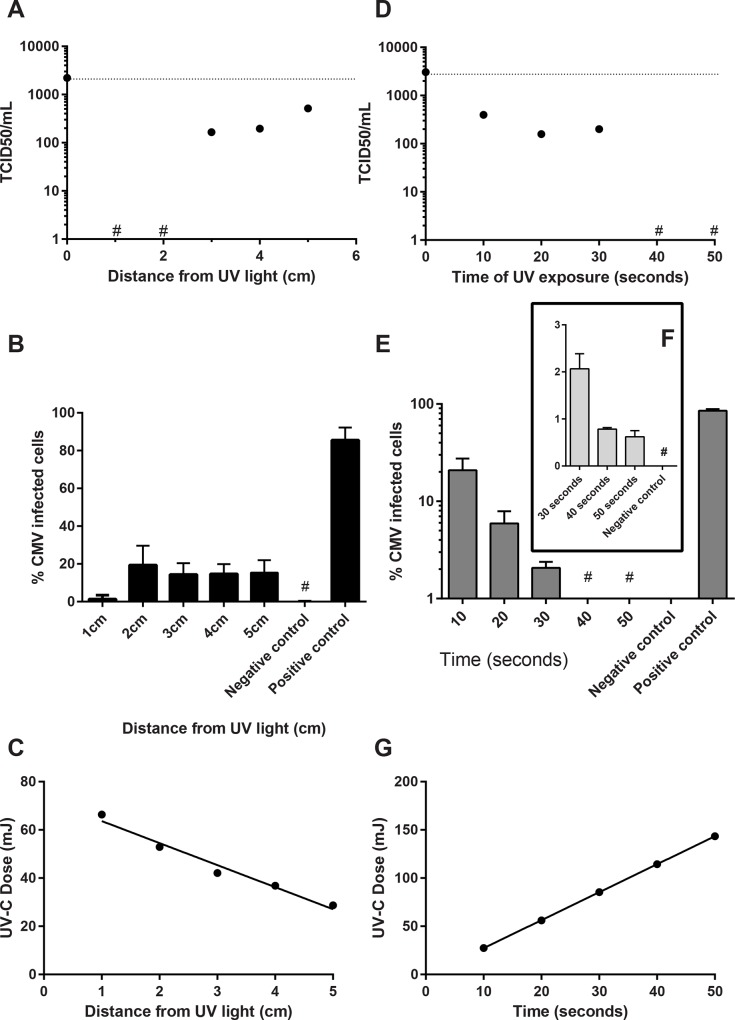
UV-C inactivation of HCMV.A—C. UV-C exposure of spiked breast milk for 10 seconds from 1 to 5 cm from the UV light source. Pasteurized breast milk was spiked with AD169 culture 1:5. The irradiated samples were diluted tenfold and inoculated on to human HFF and the TCID50 calculated using the method described by Reed and Muench [15]. A. Results are presented as TCID50/mL. Breast milk samples with values below the limit of detection are designated (*). B. Irradiated samples were inoculated onto HFF, centrifugally enhanced and cells were analysed by immunofluorescence at 7 days post infection. Results are presented as % infected cells. C: UV dose delivered. D—F. UV-C exposure of spiked breast milk at 5 cm from the UV light source for different durations. D: Pasteurized breast milk was spiked with AD169 and samples were irradiated at 5 cm from the UV light source for 10 to 50 seconds. The irradiated samples were assessed by TCID50. Breast milk samples with values below the limit of detection are designated (*). E. Irradiated samples were inoculated onto HFF, centrifugally enhanced and cells were analysed by immunofluorescence at 7 days post infection. Results are presented as % immunofluorescently labelled cells. * <1% of cells fluorescently labelled. F: Inset shows results for 30, 40 and 50 seconds exposure. G: UV dose delivered. Where error bars are present, images show mean ± standard deviation.